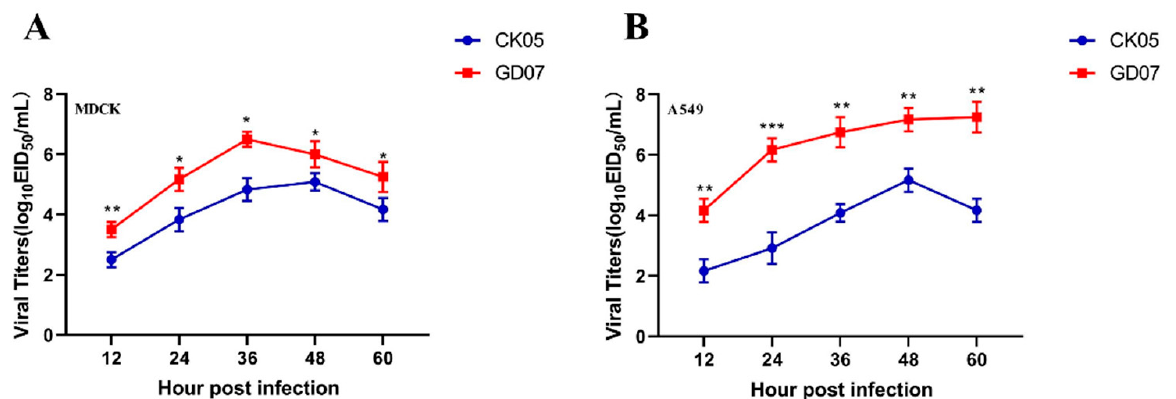
Figure 3. Viral titers at different time points in MDCK ( A ) or A549 ( B ) cells. The two strains (CK05 and GD07) infected cells with an MOI of 0.01 (10 5 cells). At 12, 24, 36, 48, and 60 hpi, cell supernatants were collected and inoculated into SPF chicken embryos. The titer of the virus at different time points was determined by EID 50 . Three independent experiments were performed in each group. * p < 0.05, ** p < 0.01, *** p < 0.001.